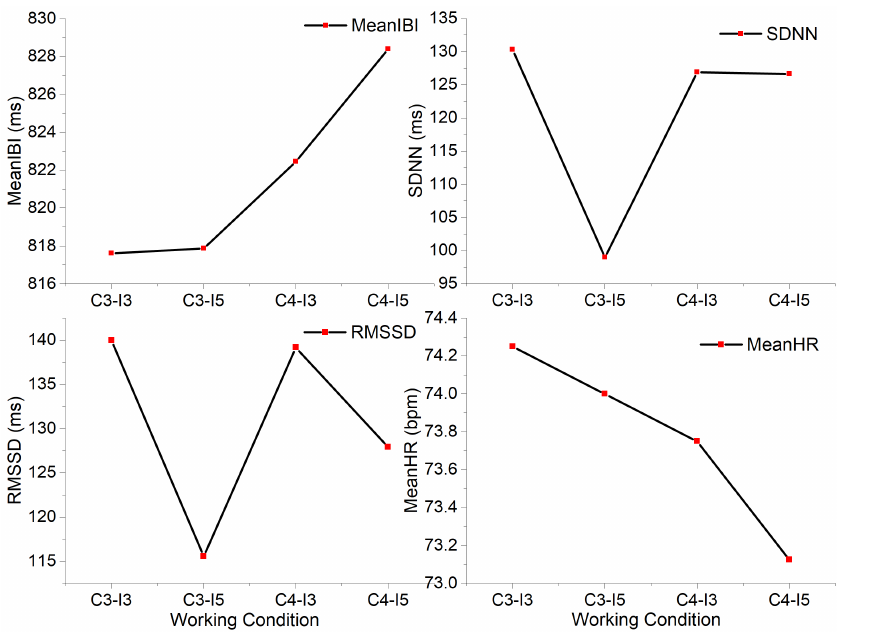
Figure 9. Trend of HRV time-domain indicators. Table 8. Frequency-domain index classification.